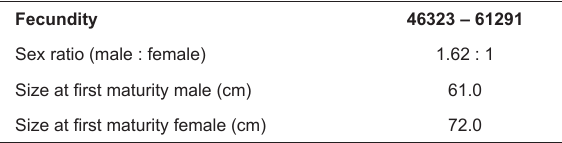
Table 2. Reproductive parameters of S. gymnopomus